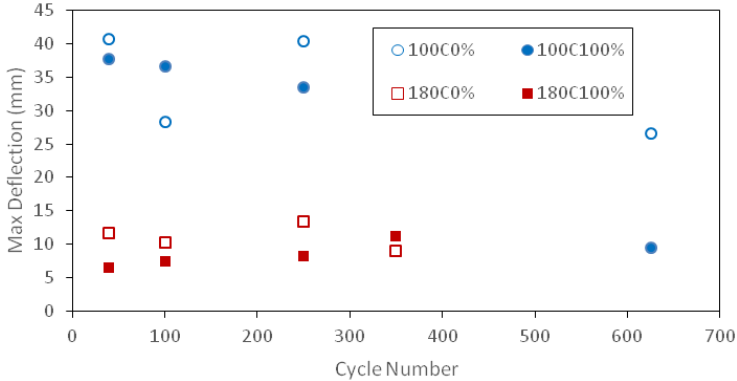
◦ C and 180 ◦ C (Cp = 2, 0% and 100% humidity).